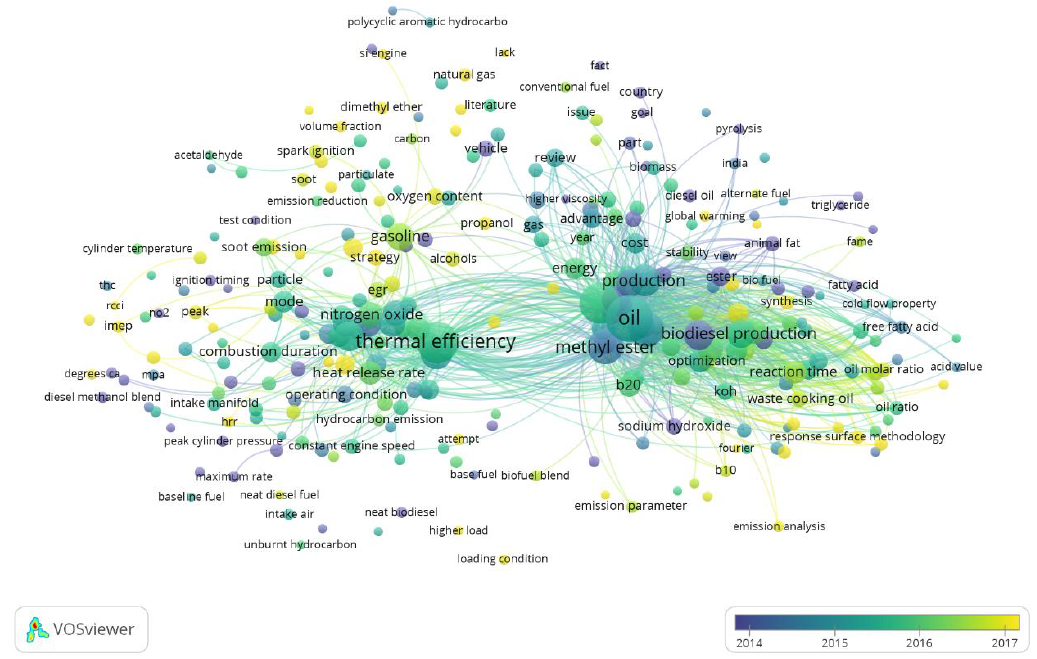
Figure 2. Research topics provided by Web of Science, Clarivate, including methanol/diesel fuel blends.